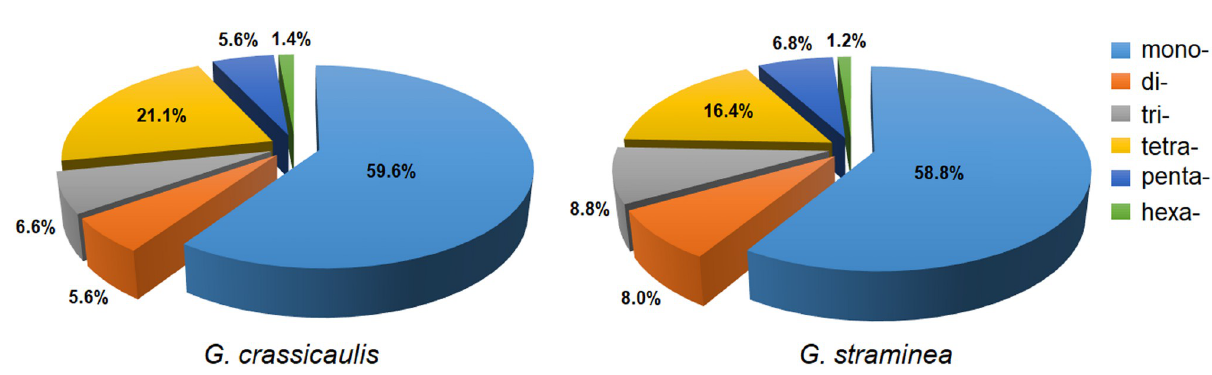
Fig 4. SSR characteristics of mitochondrial genomes of Gentiana crassicaulis and G . straminea .